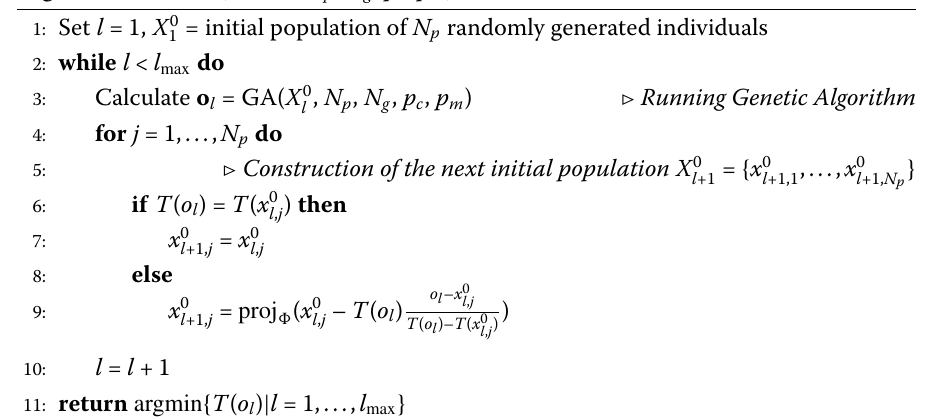
Algorithm 1 GMA ( l max , T , N p , N g , p c , p m